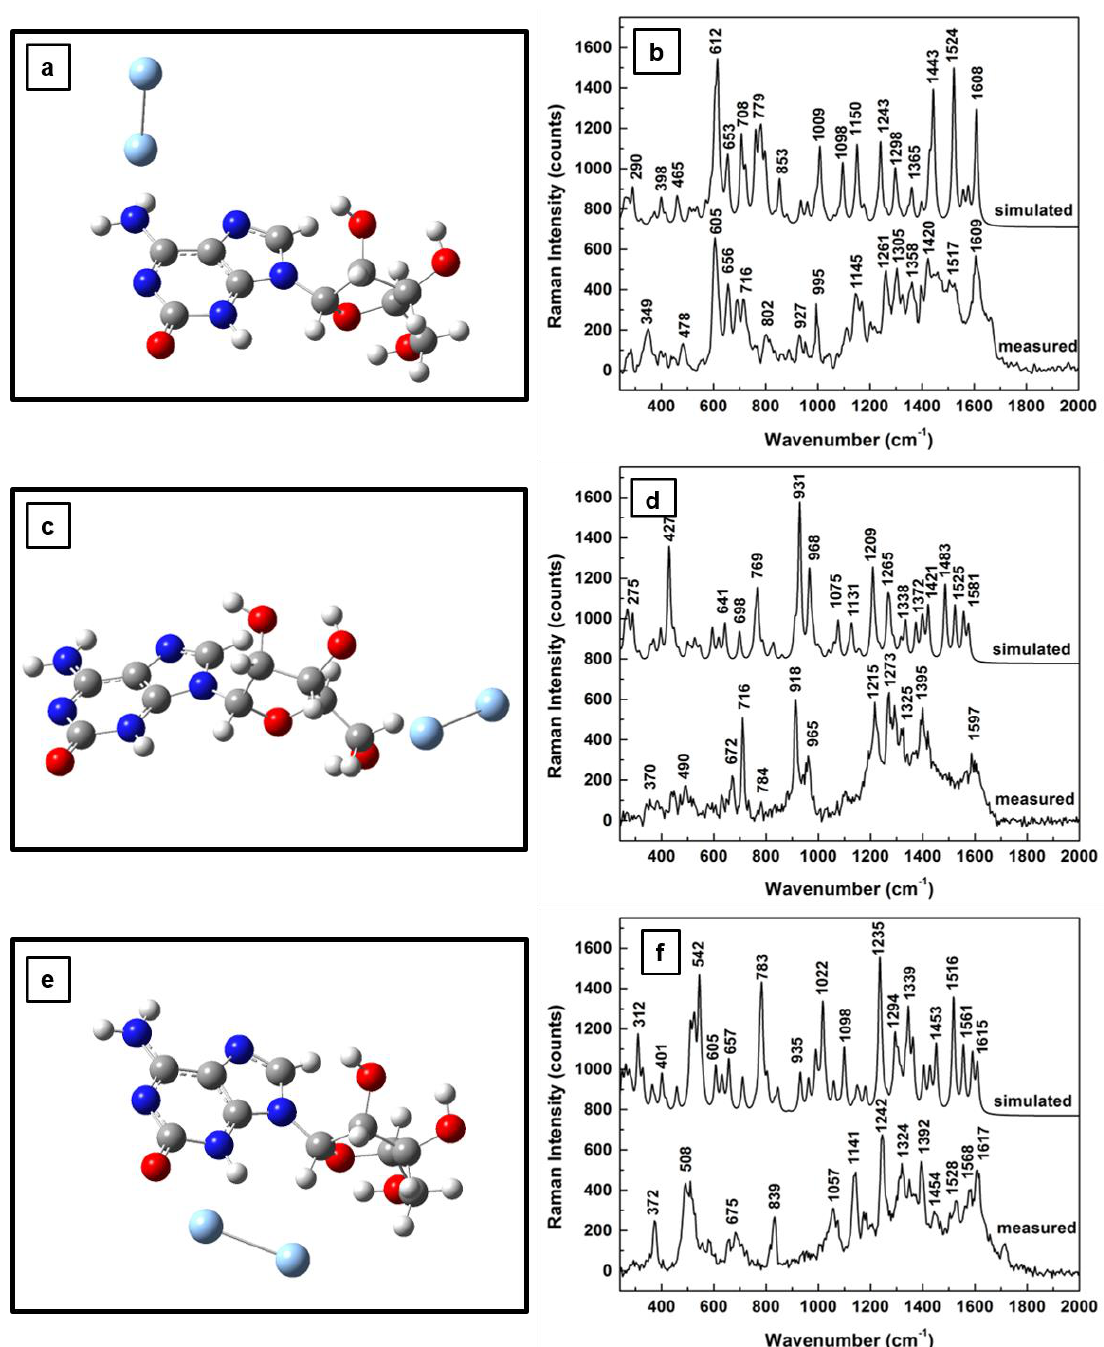
Figure 4. Structural representations of the first step of 2-electron oxidation of adenosine in the proximity of a silver dimer: ( a ) dimer in the proximity of NH 2 site of adenine ring, ( c ) dimer in the vicinity of carbinol moiety, and ( e ) dimer between the C=O and OH chemical bonds of the adenine and ribose structural units, respectively. ( b , d , f ) Theoretically estimated and experimentally recorded Raman vibrational spectra associated with ( a , c , e ), respectively. The spectra are vertically translated for easier visualization and appropriately labeled.